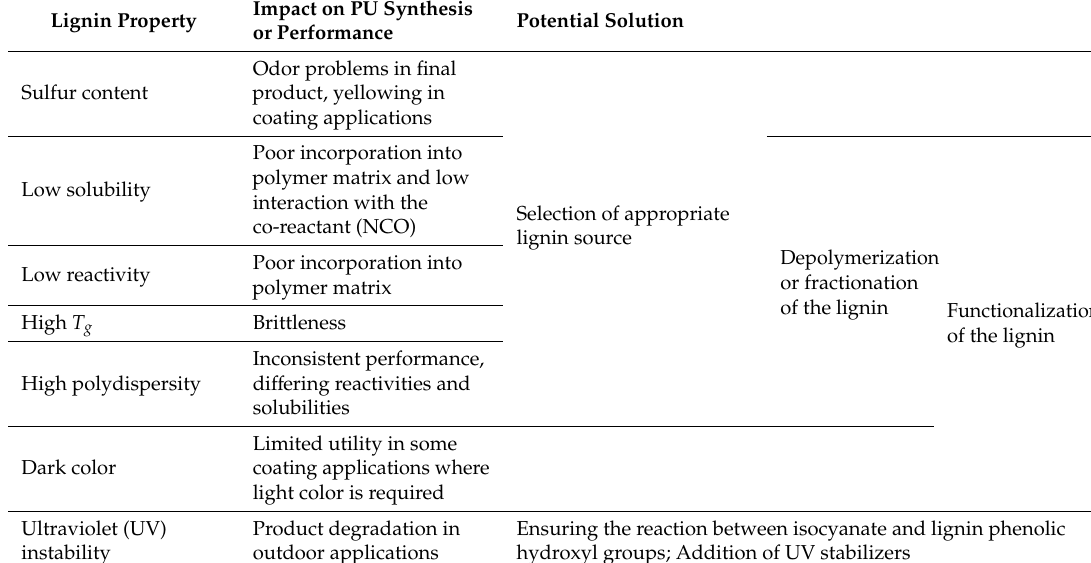
Table 1. Potential challenges for integration of lignins into polyurethane (PU) products and possible mitigation